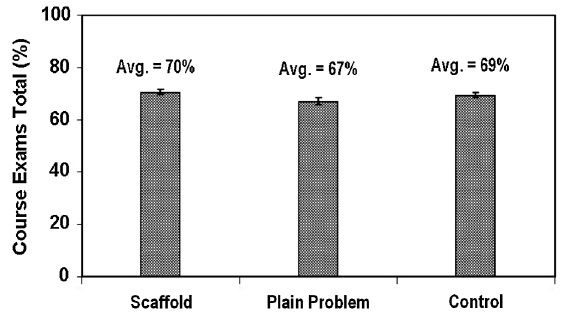
FIG. 8. Student exam totals for a calculus-based introductory mechanics course.